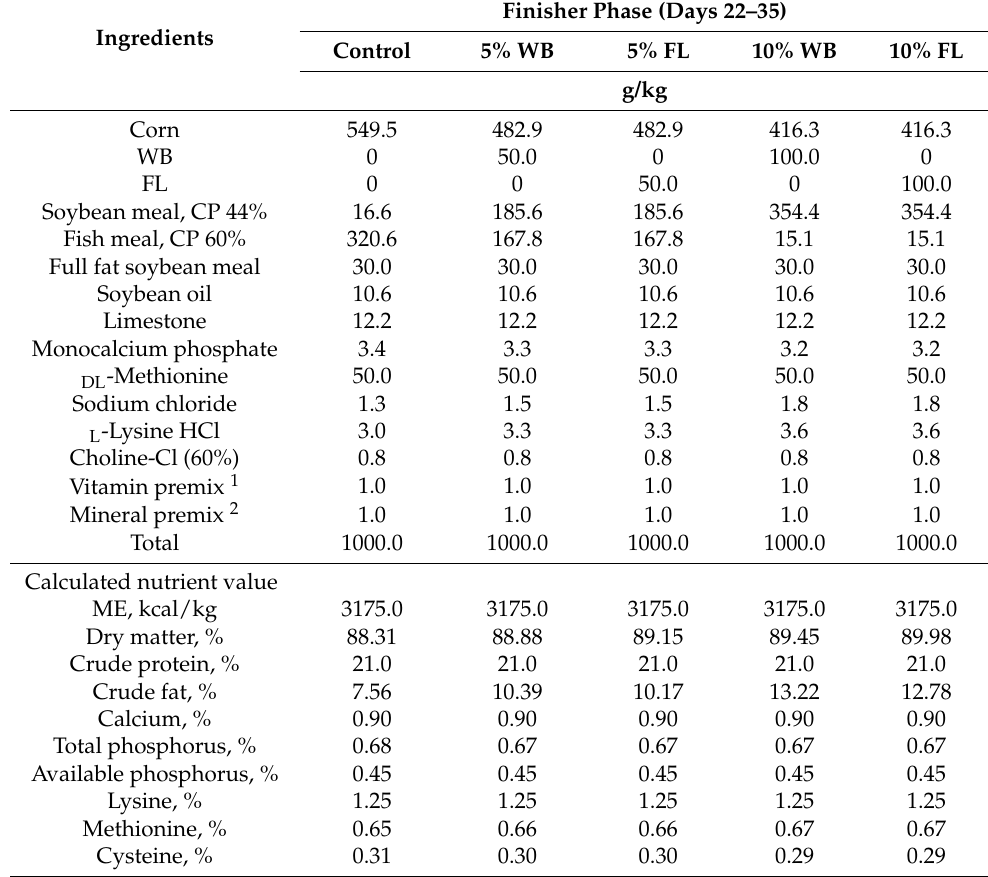
Table 2. Ingredients of the experimental diets for broilers at the finisher phase (days 22–35).